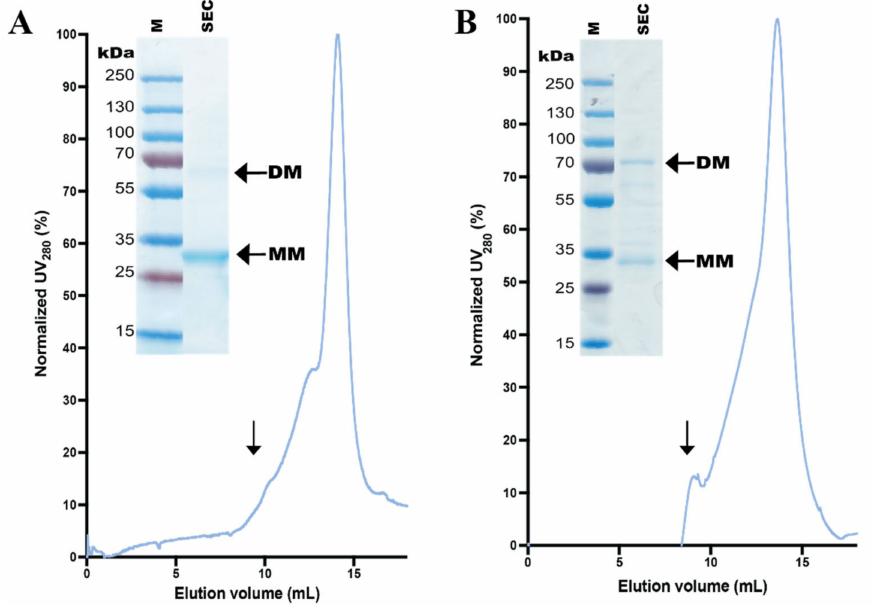
Figure 6. Size-exclusion chromatography (SEC) analysis of N-terminal hZIP1 fusions. ( A ) SEC profile of reverse-immobilized metal ion affinity chromatography-pure hZIP1 (i.e., TEV protease- digested His-TEV-hZIP1). ( B ) SEC profile of StrepII-tag affinity-pure StrepII-TEV-hZIP1. Normalized SEC chromatograms were obtained after separation on Superdex 200 Increase 10/300 GL column where A 280 was monitored. Arrows indicate the estimated elution positions of the void volume. Insets: Coomassie staining of the resulting SEC-pure SDS-PAGE-separated samples (SEC). M: marker. Arrows indicate the monomeric (MM) and dimeric (DM) forms of the respective N-terminal hZIP1 fusions, with the predicted MWs of His-TEV-free hZIP1 of 32.5 kDa (MM) and 65 kDa (DM), and StrepII-TEV-hZIP1 of 36.5 kDa (MM) and 73 kDa